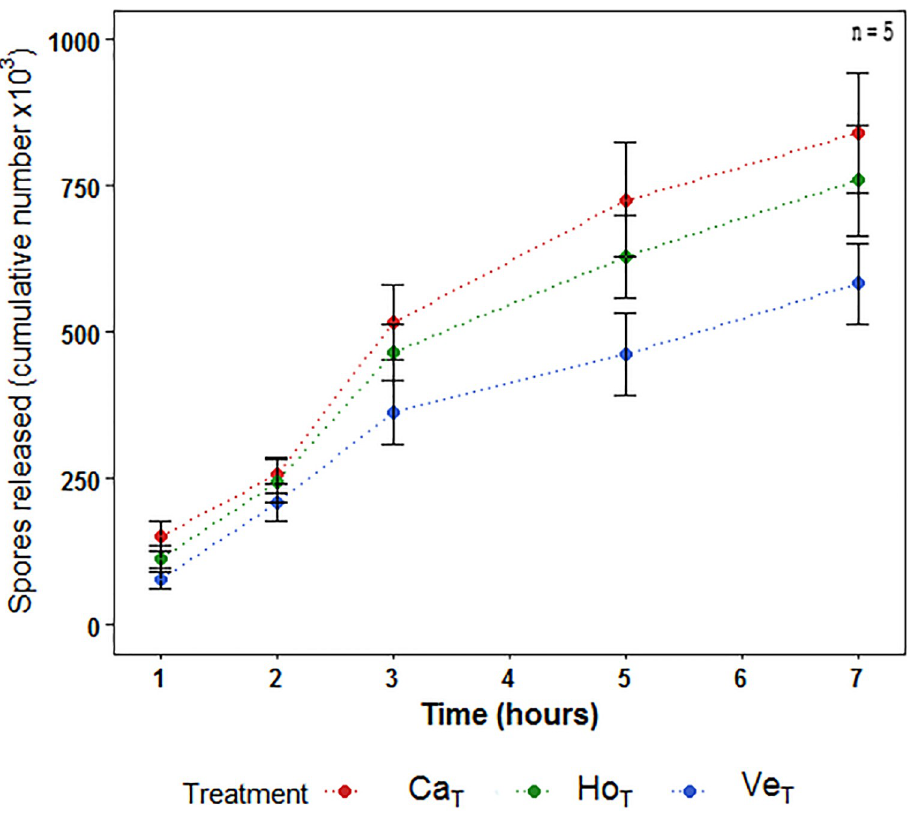
Fig 5. Spore released. Accumulated spores released by sori of Lessonia spicata (number of spores released mL -1 , average ± S.D (n = 5). Ca; Cachagua, Ho; Horco´n, Ve; Ventanas. T; treatment.